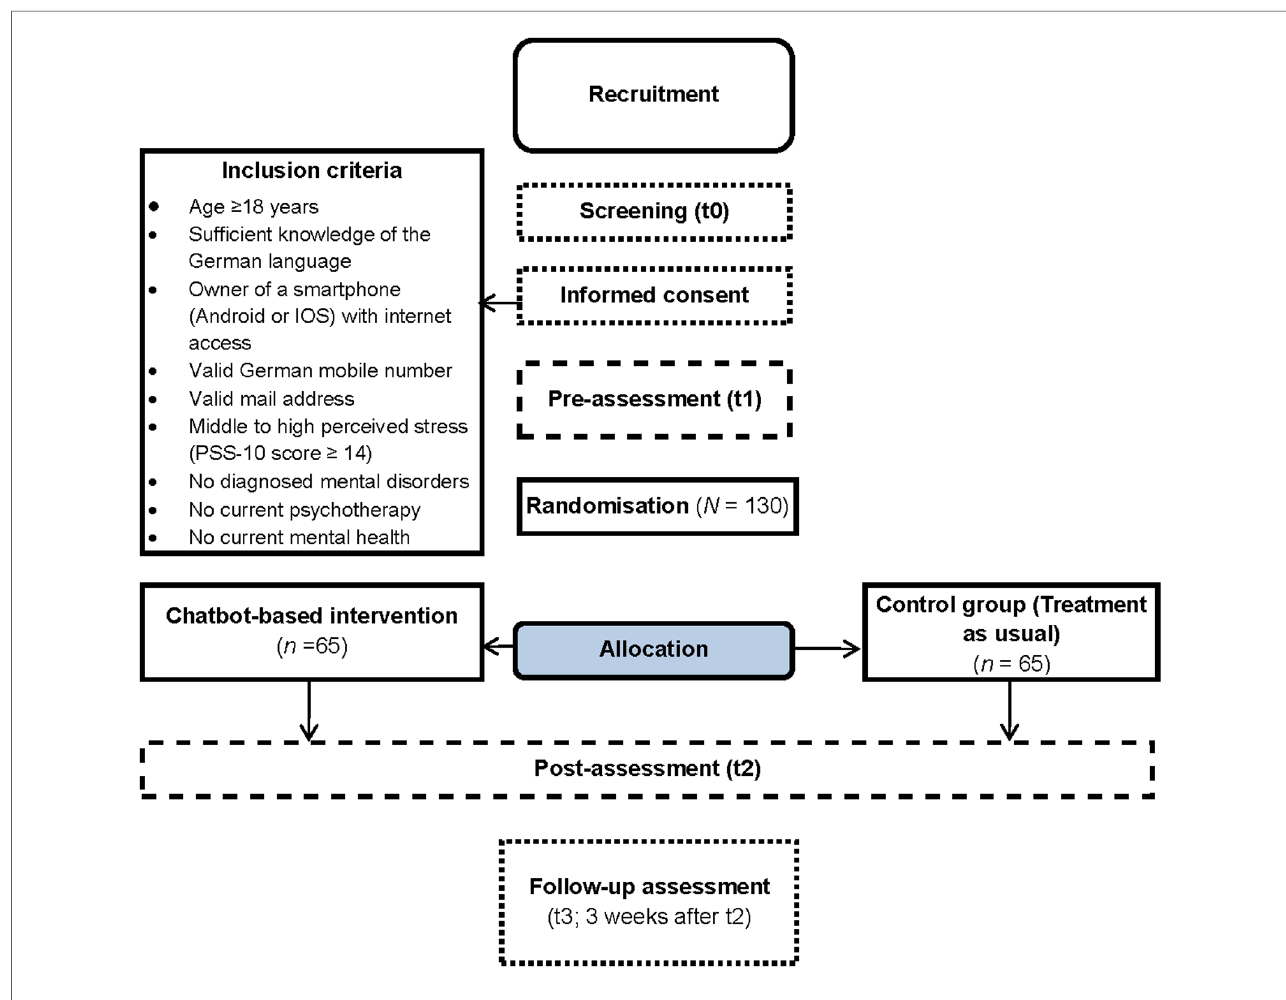
FIGURE 1 Flow chart of the planned study